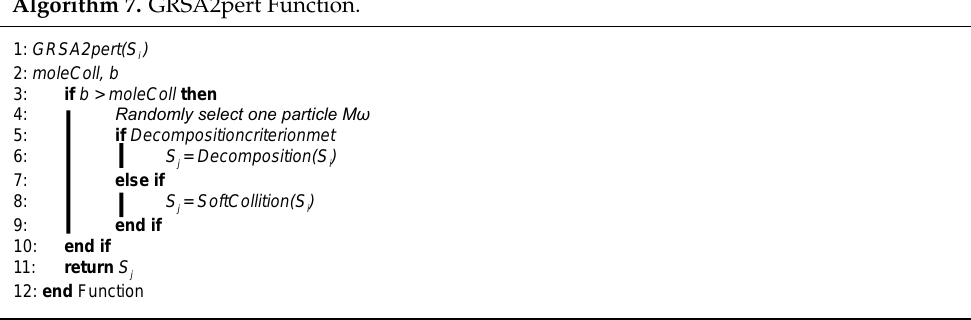
Algorithm 4.1 GRSA2pert Function